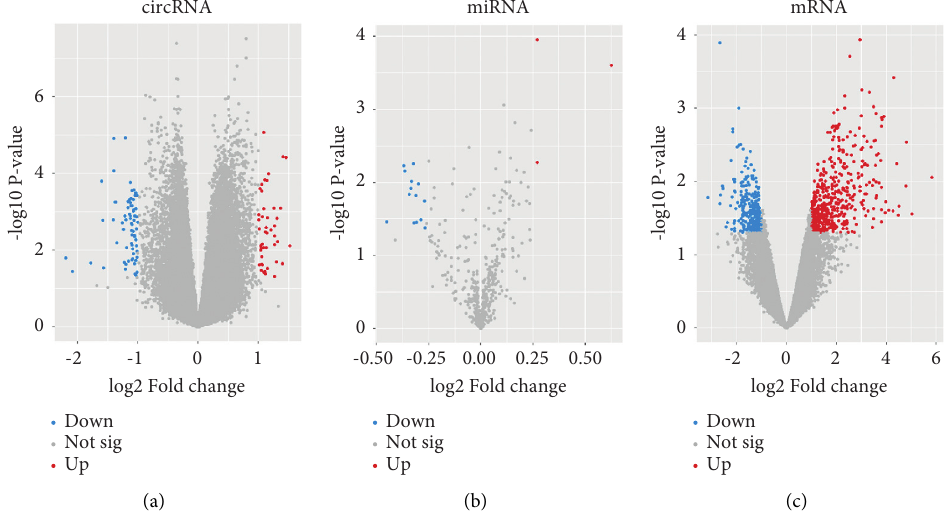
Figure 1: Volcano plots for each microarray. (a) Volcano plots of DEcircRNAs based on GSE115733. (b) Volcano plots of DEmiRNAs based on GSE59421. (c) Volcano plots of DEmRNAs based on GSE97320. DEcircRNAs, differentially expressed circular RNAs; DEmiRNAs, differentially expressed microRNAs; DEmRNAs, differentially expressed